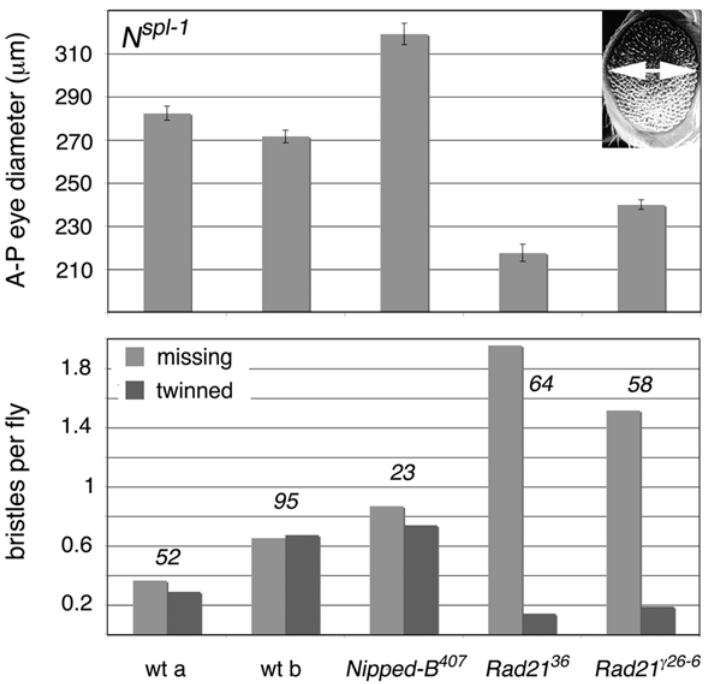
Figure 6. Dominant effects of Nipped-B and Rad21 mutations on Notch - split ( N spl-1 ) mutant phenotypes. The top panel compares the eye phenotype in two wild-type backgrounds (wt a, Oregon R; wt b, Canton S), to flies heterozygous for Nipped-B 407 , Rad21 36 ( vtd 36 ), and Rad21 c 26-6 ( vtd c 26-6 ). Eye diameter was measured as shown in the upper right. At least 30 eyes were scored for each genotype. Error bars are standard errors. The bottom panel shows the effects of the heterozygous Nipped-B and Rad21 mutations on the four scutellar macrochaete (large bristles). The number of flies scored for bristles is given above the bars.